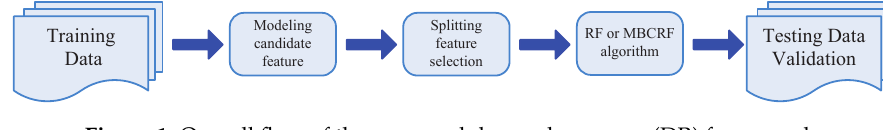
Figure 1. Overall flow of the proposed demand response (DR)